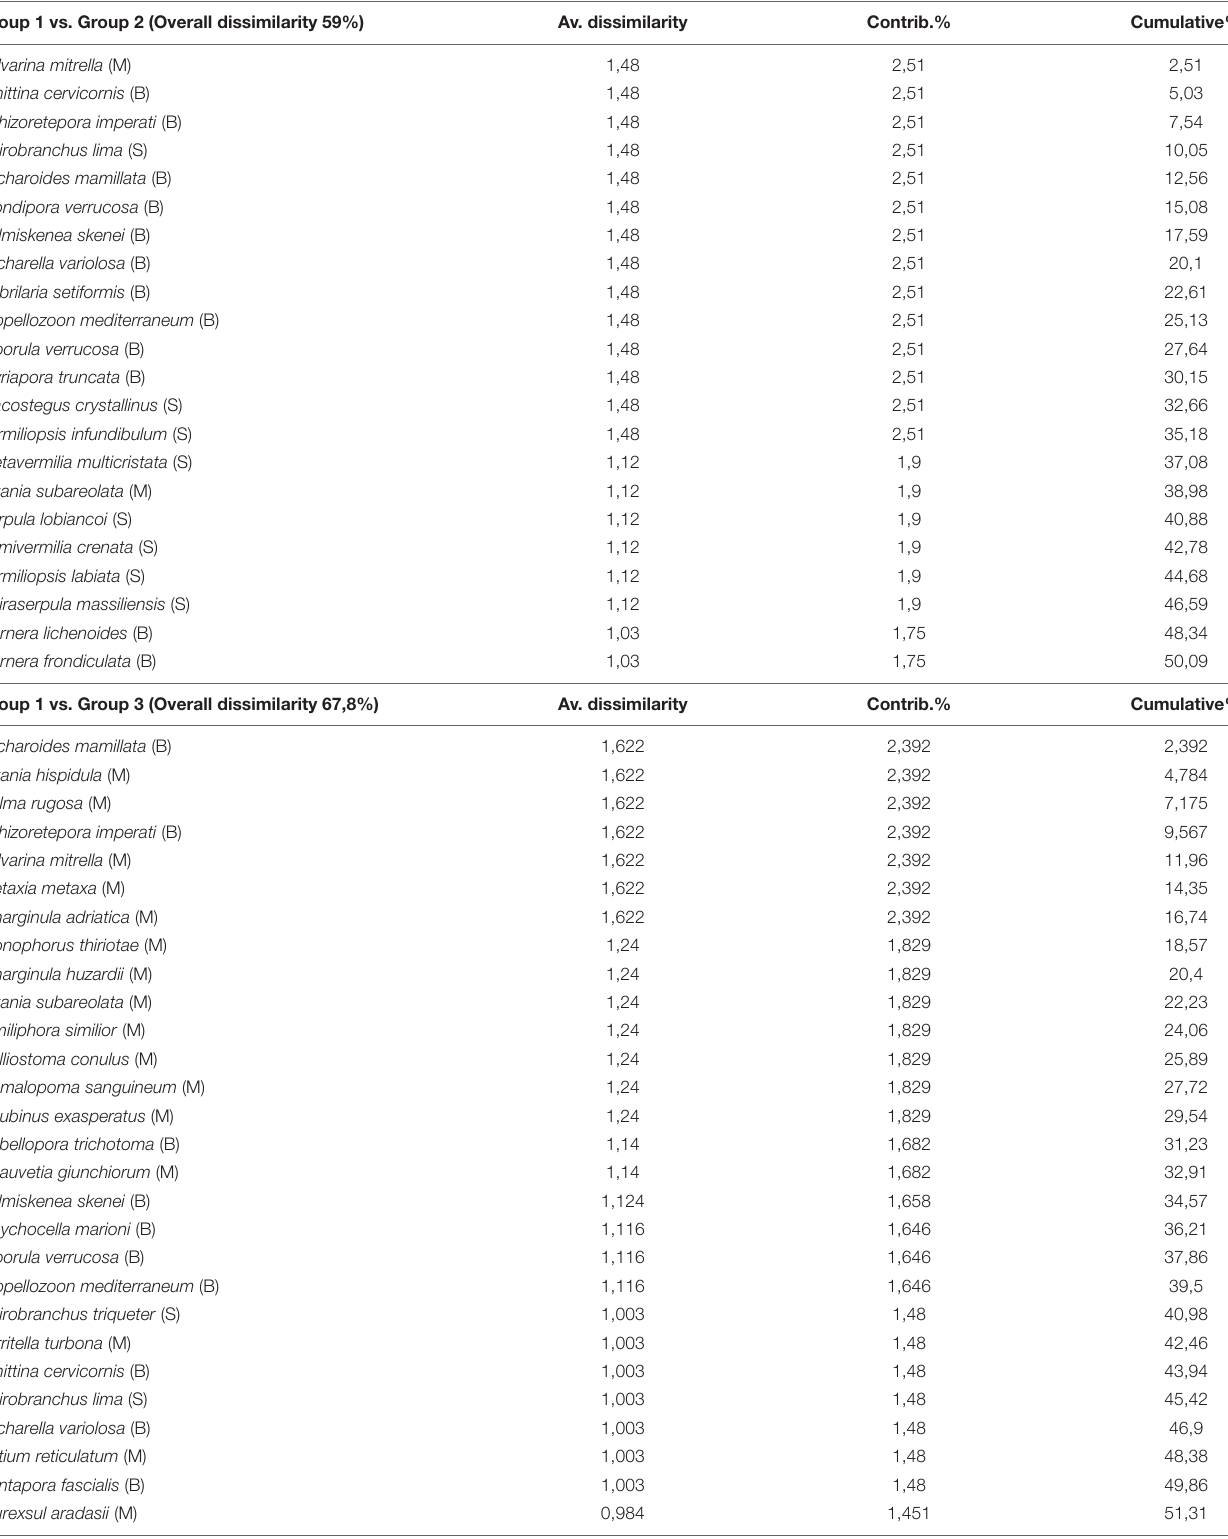
TABLE 3 | Results of SIMPER analysis for identification of species contributing the most to faunal dissimilarity between habitats. Group 1 vs. Group 2 (Overall dissimilarity 59%) Av. dissimilarity